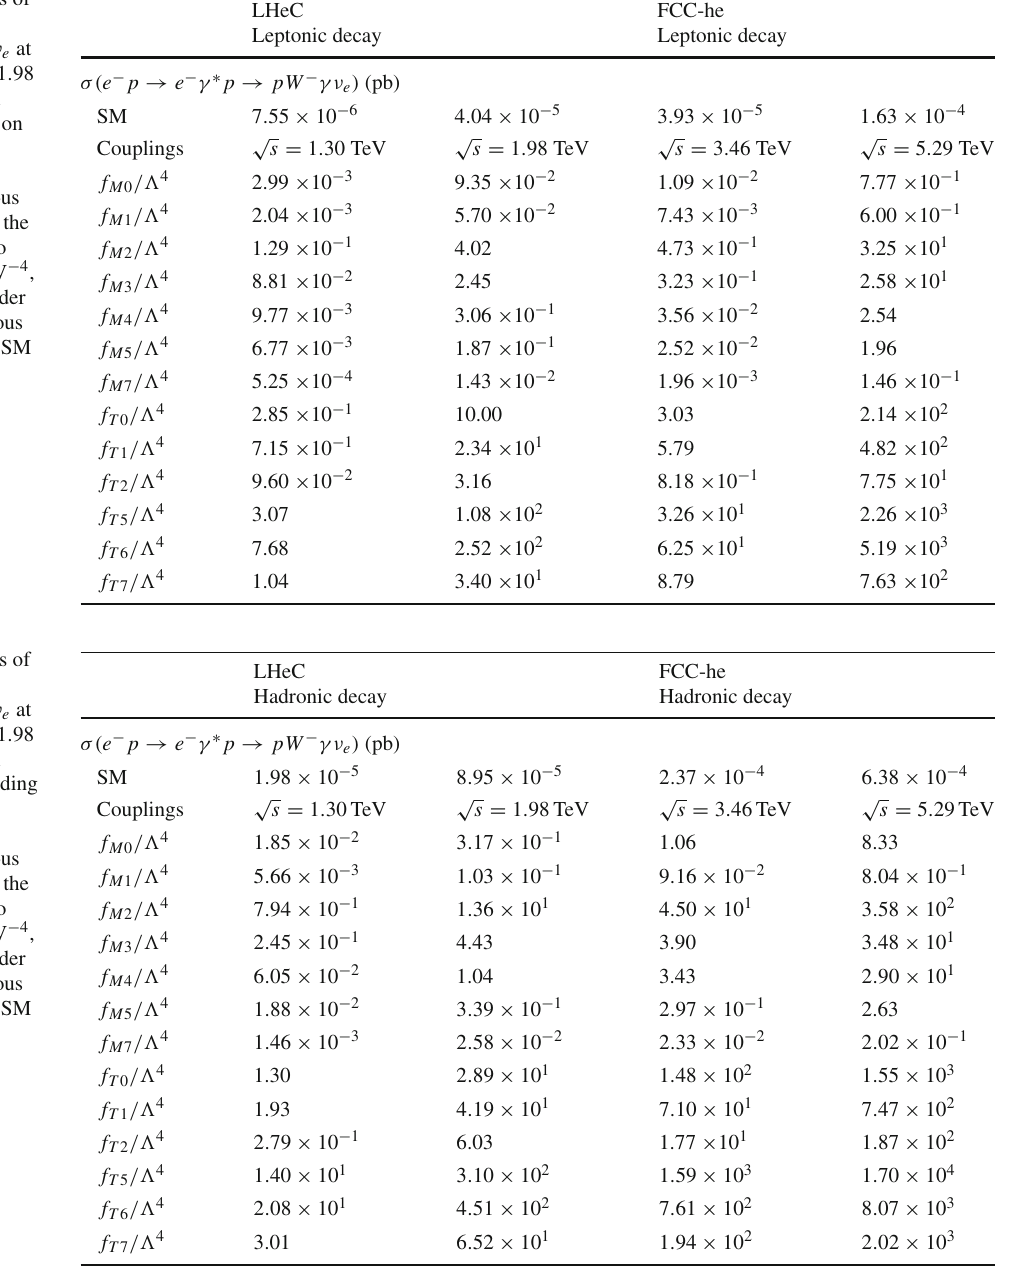
the process e − p → e − γ ∗ p → pW − γν e at the LHeC with